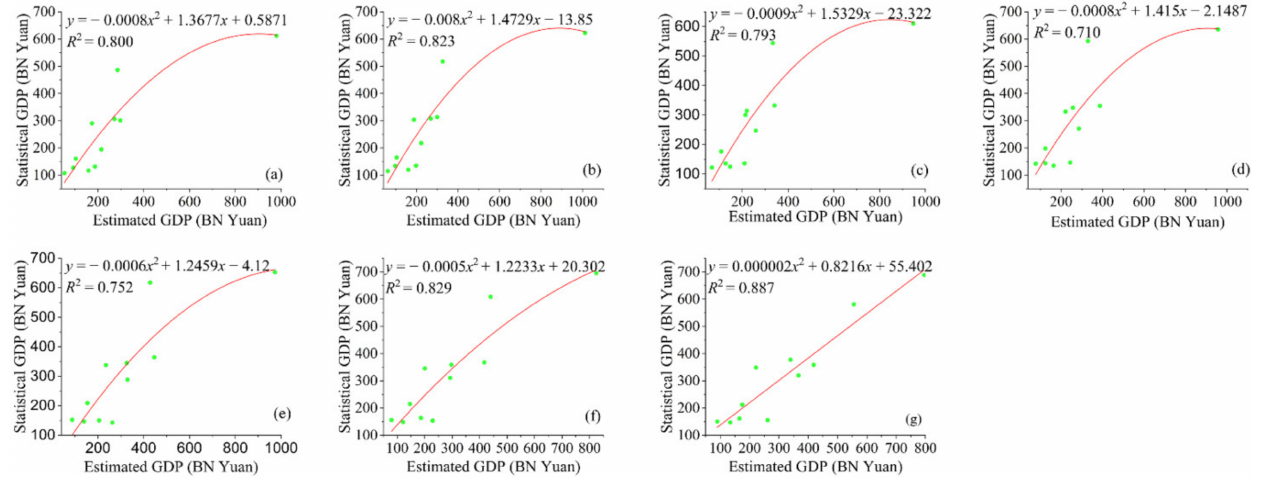
Figure 12. Correlations between annual statistical GDP and estimated GDP at the prefectural scale for 2013 ( a ), 2014 ( b ), 2015 ( c ), 2016 ( d ), 2017 ( e ), 2018 ( f ), and 2019 ( g